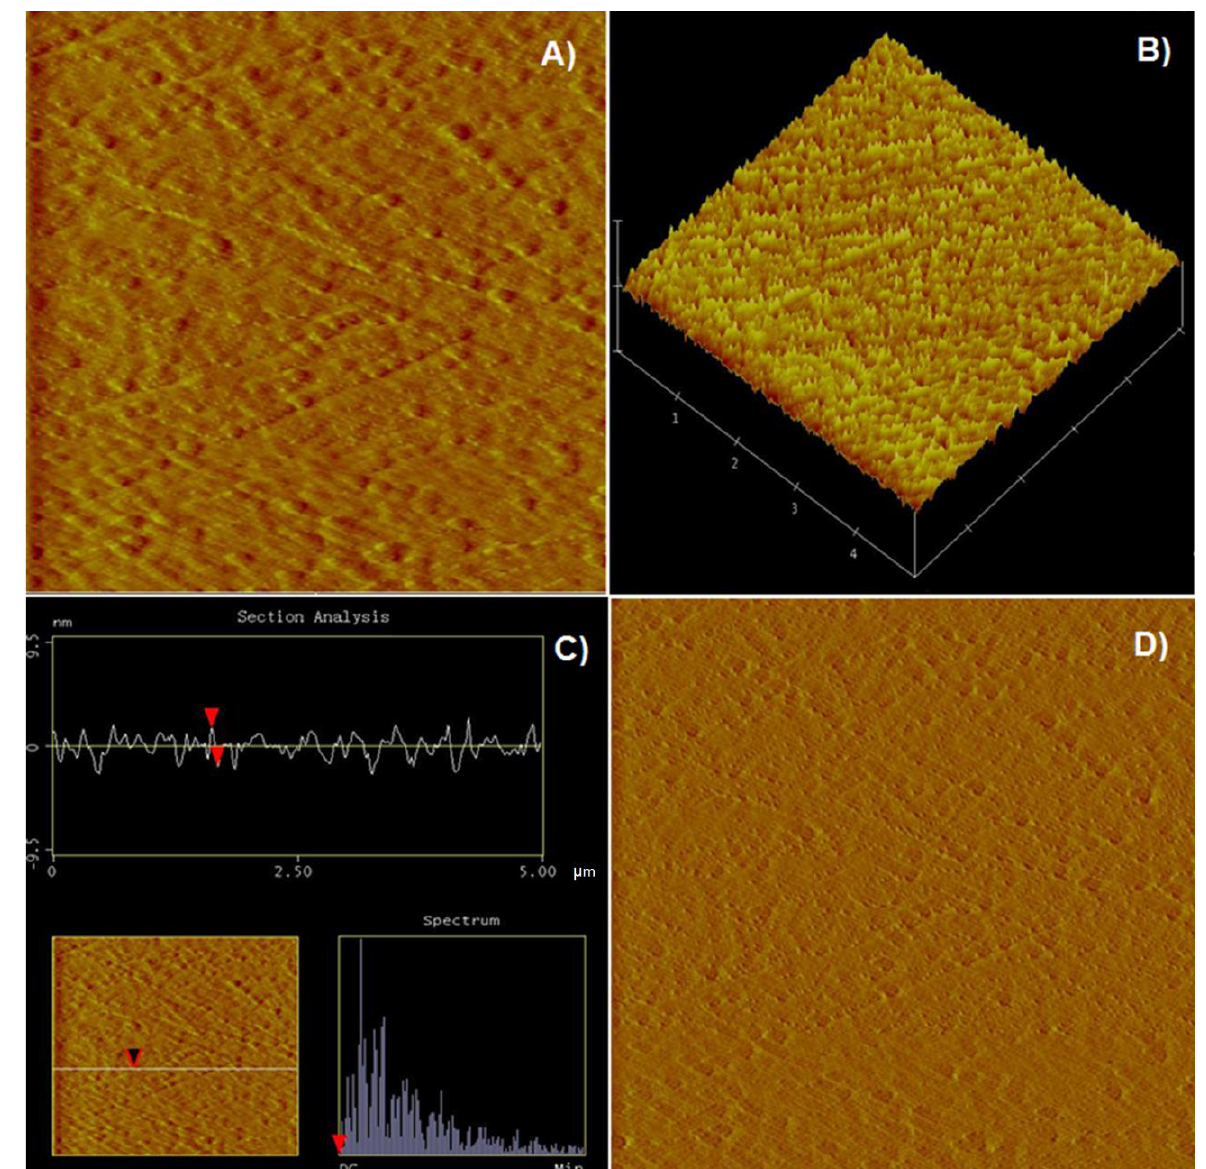
Figure 9. AFM images of a bornite surface soaked in the 5 × 10 − 5 M PAX solution at pH 6 for 10 min. ( A ) The 5 µm × 5 µm height image with a data scale of 20 nm, ( B ) the 3D image, ( C ) the section analysis (the red arrows indicate the top and the bottom of an average asperity) and ( D ) the deflection image with a data scale of 10 nm.